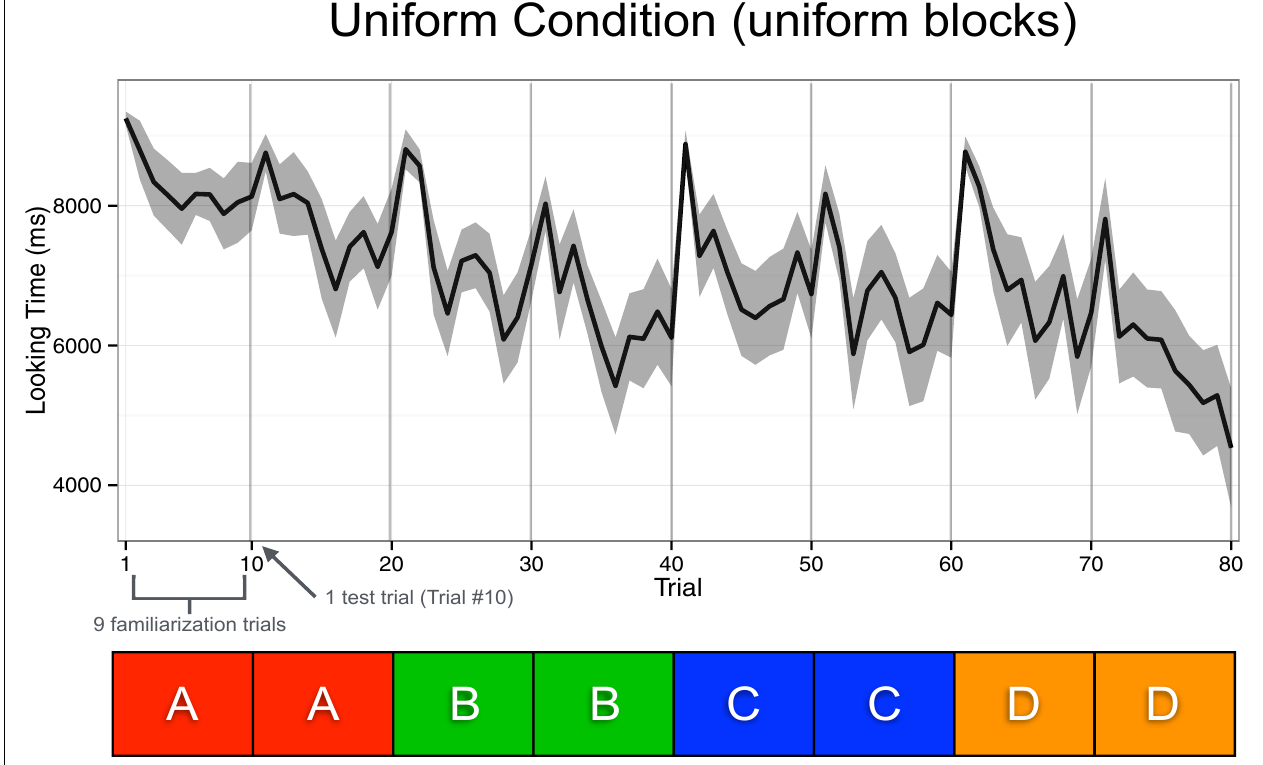
FIGURE 4 | Raw looking times across trials throughout the Uniform condition. The test trials are depicted by the vertical lines (trials 10, 20, 30, etc.), and the familiarization trials were trials 1–9 in every half block.